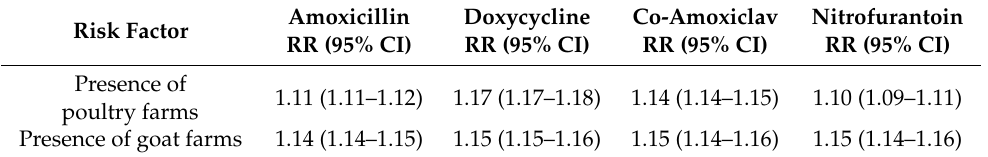
Table 3. Crude two-by-two associations per type of antibiotic with presence of poultry or goat farms.